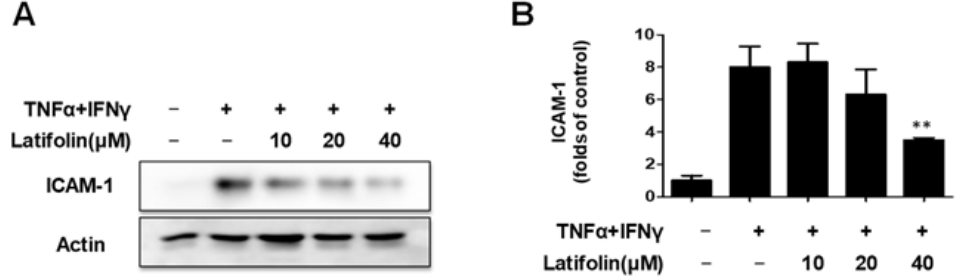
Figure 2. Effects of latifolin on TNF- α /IFN- γ -induced ICAM-1 expression ( A , B ). The data are represented as the mean ± SD ( n = 3). ** p < 0.01 vs. TNF- α /IFN- γ -treated group.